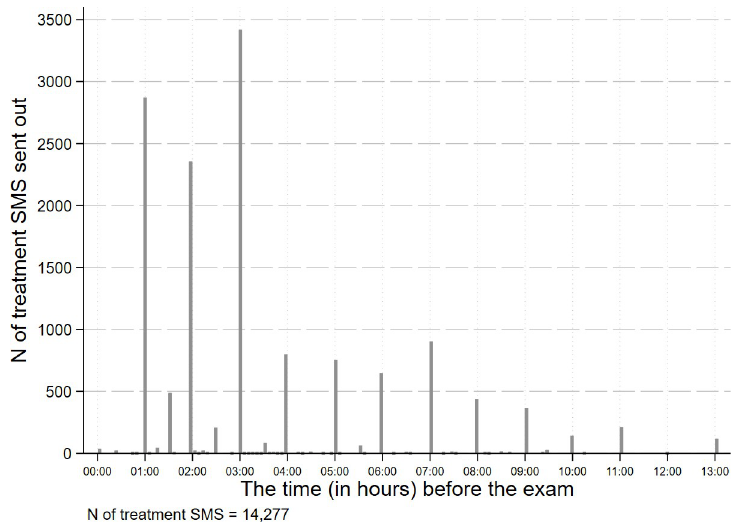
Fig 2. The time (in hours) relative to the exam when the treatment SMS was